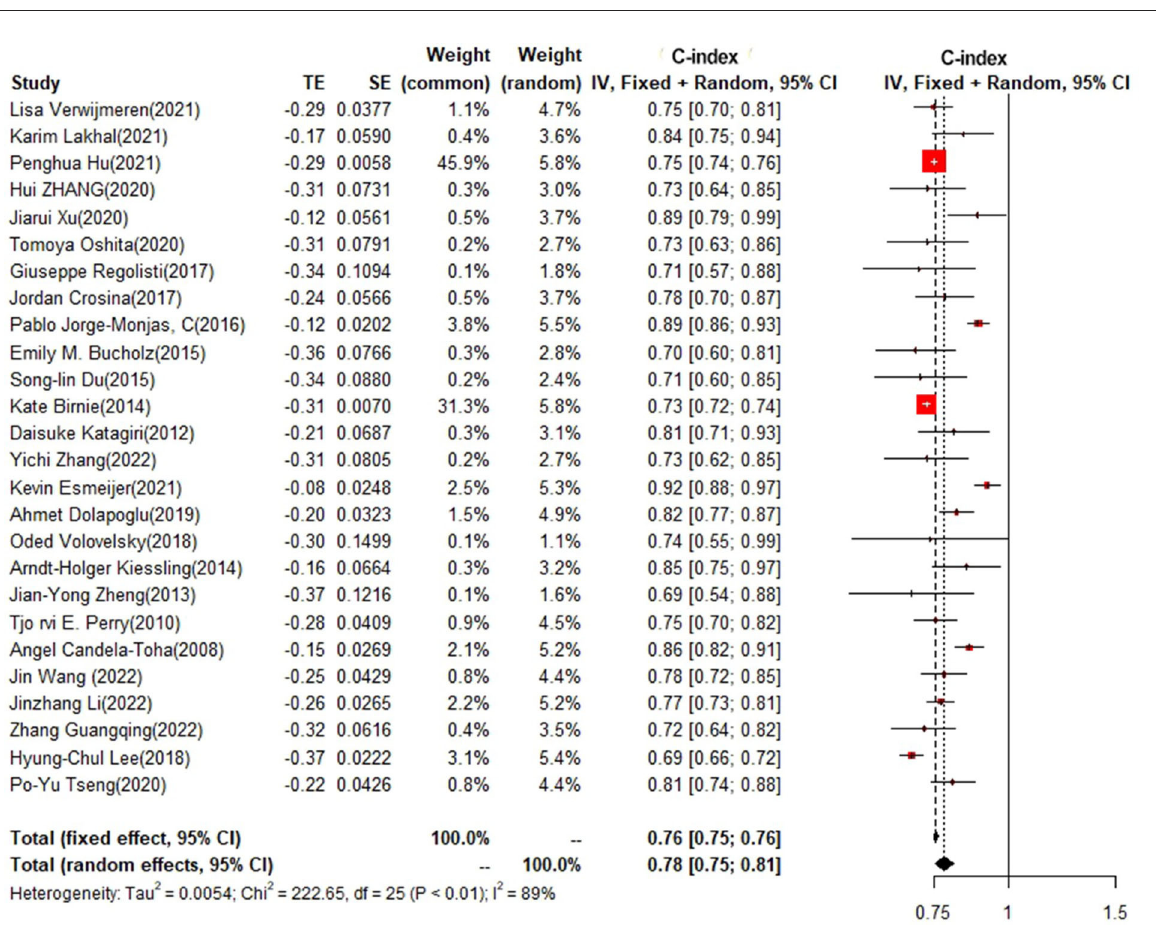
FIGURE7 C-index in the training set: logistic